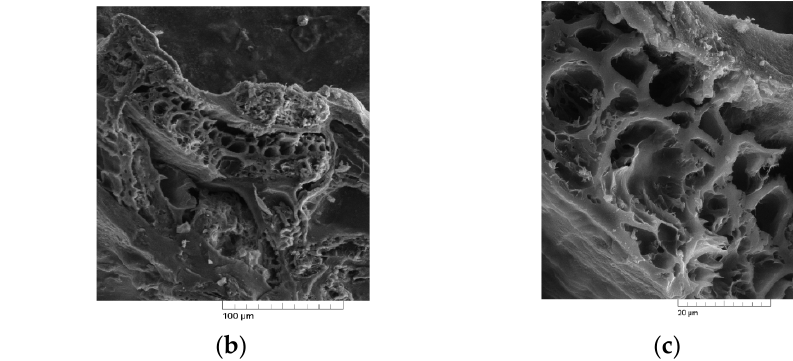
Figure 8. Surface morphology of: ( a )—initial chitosan, × 200; ( b )—GO-Ch (sample No.4), × 100; ( c )—GO-Ch (sample No.4), × 200.